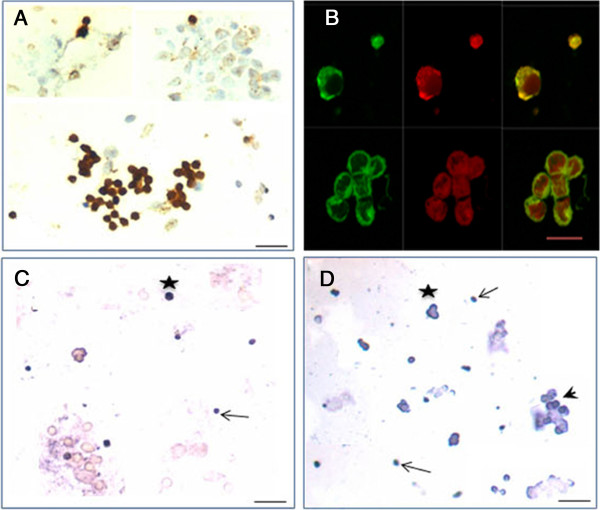
FSH receptor studies on sheep OSE smears. (A) FSH receptors are immuno-localized on the stem cells and germ cell nests ‘cysts’ whereas the epithelial cells remain distinctly negative. (B) Confocal imaging of FSHR localization on the stem cells. VSELs show nuclear staining whereas the OGSCs have cell surface expression of FSHR. In situ hybridization results using specific oligo probes for (C) Fsh-r1 and (D) Fsh-r3 transcripts on FSH treated sheep OSE smears. As evident Fsh-r1 transcript is observed in the nuclei of both VSELs (arrow) and OGSCs (asterix). Fsh-r3 transcript is localized both in the nuclei and cytoplasm even in the germ cell nests ‘cysts’. Presence of Fsh-r3 in both cytoplasm and nuclei suggests active involvement of this transcript during FSH action on the stem cells.